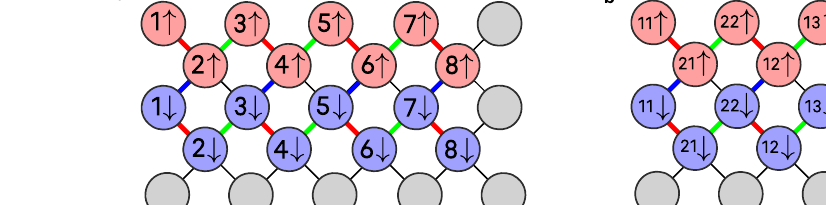
Nature Communications| (2022)